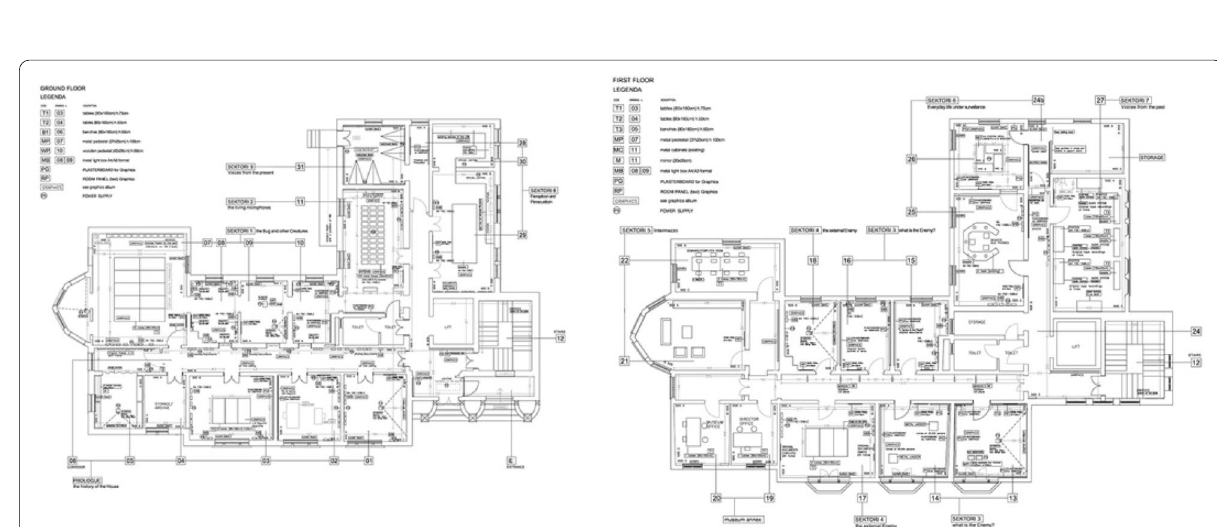
Fig. 12 Plan of ground floor and the first floor of museum is “The House of Leaves”, Studio Terragni